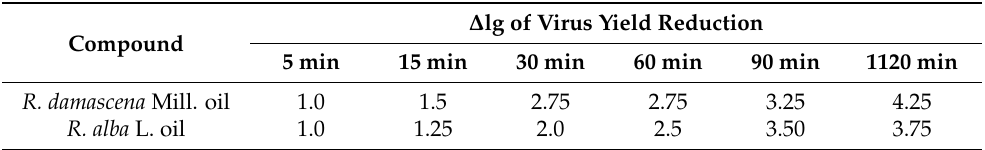
Table 4. Protective effect in pretreatment of healthy cells of Rosa damascena Mill. and Rosa alba L. essential oils.